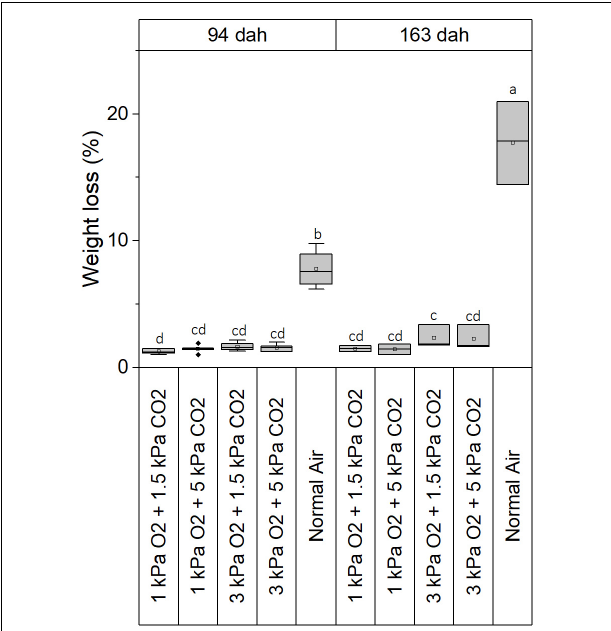
FIGURE 1 | Boxplots representing the weight loss of ‘Caraflex’ cabbages stored under different storage conditions 94 dah and 163 dah. Statistical differences ( p < 0.05) between treatments are indicated by different letters.